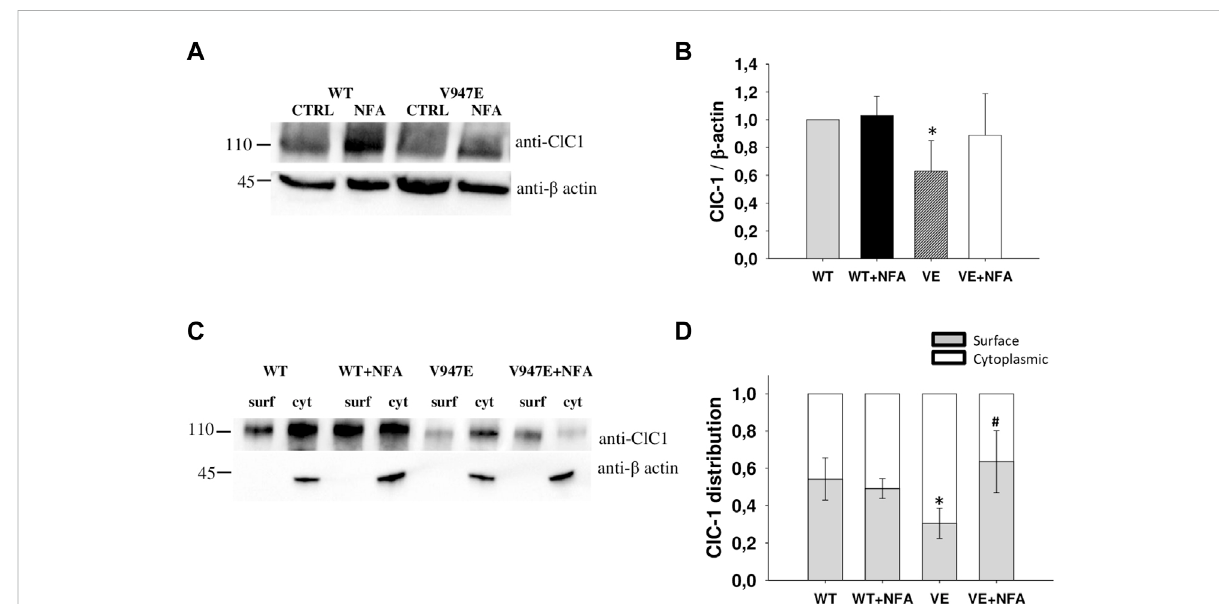
FIGURE 3 ClC-1 protein expression in HEK293T cells transfected with WT and V947E ClC-1 channels and effects of 50 µM NFA incubation for 24 h. (A) . Representative western blot of total ClC-1 and β -actin proteins from transfected HEK293T with WT and V947E in the absence or presence of 50 μ M NFA. (B) . Quanti fi cation of ClC-1 total protein expression level. The ClC-1 signal of each column was standardized to the β -actin signal and normalizedtoWTonthesameblot.Eachbaristhemean±S.E.M.fromthreeindependentexperiments.Asterisksdenoteasigni fi cantdifference ( p < 0.05)betweenV947EinthecontrolconditionandafterNFAtreatment. (C) .RepresentativewesternblotofsurfaceandcytoplasmicClC-1and β - actin proteins obtained from the biotinylation assay of transfected HEK293T cells incubated for 24 h in the absence or presence of 50 μ M NFA. (D) . Quanti fi cation of surface and cytoplasmic ClC-1 protein distribution. Each bar is the mean ± SD from three independent experiments (*at least p < 0.05 vs WT in the control condition, # at least p < 0.05 vs V947E in the control